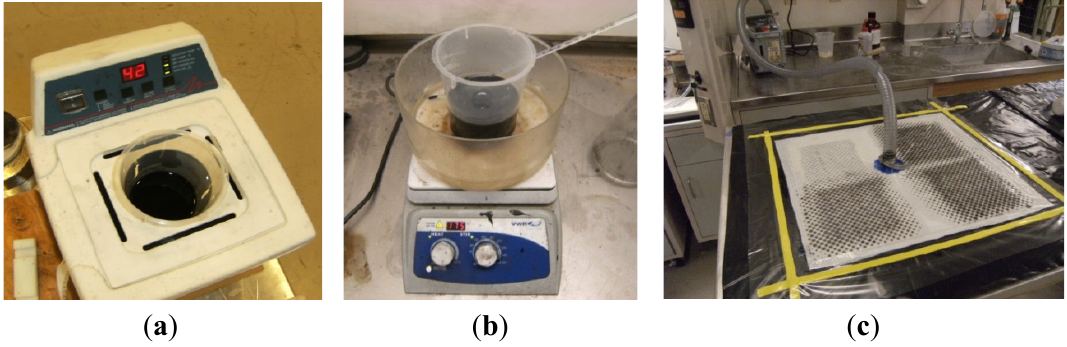
Figure 1. Fabrication of multi-scale epoxy/carbon woven fabric composite specimens: ( a ) sonication of COOH-MWCNTs in the epoxy resin; ( b ) stirring of the COOH-MWCNTs in the epoxy resin; and ( c ) the vacuum environment applied to the composite specimens during the curing of the epoxy.